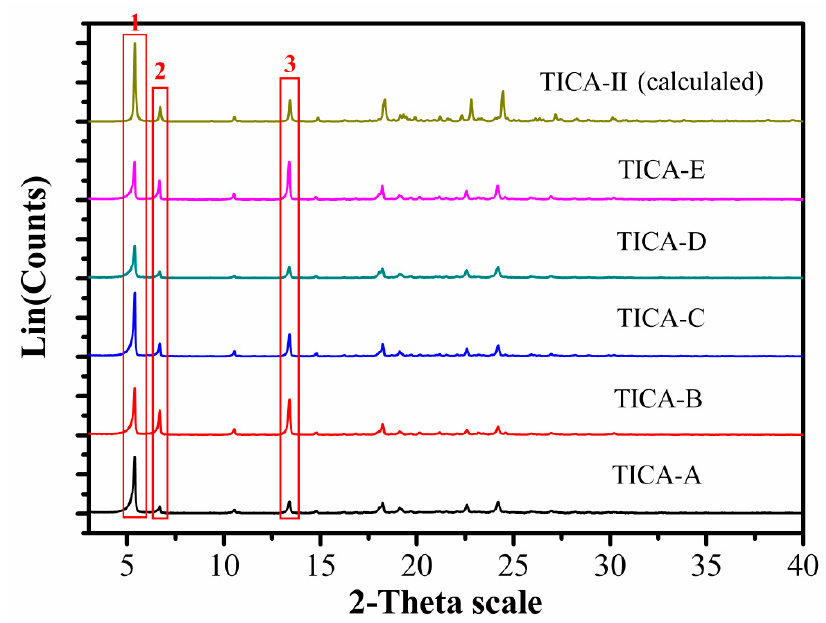
Figure 7. Overlay of XRD of TICA crystal habits and calculated XRD pattern of TICA form Ⅱ. Table 3. The PXRD of TICA crystal habits and calculated from single-crystal diffraction results .